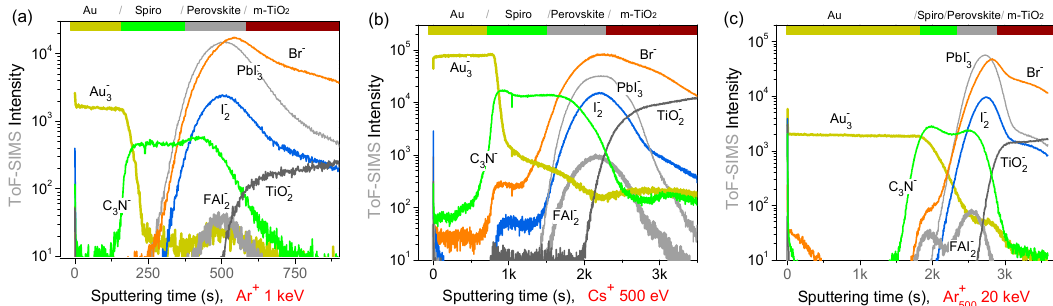
Figure 8. ToF ‐ SIMS depth profiles of PSCs with ( a ) 1 keV Ar + , ( b ) 500 eV Cs + , and ( c ) 20 keV Ar 500+ .